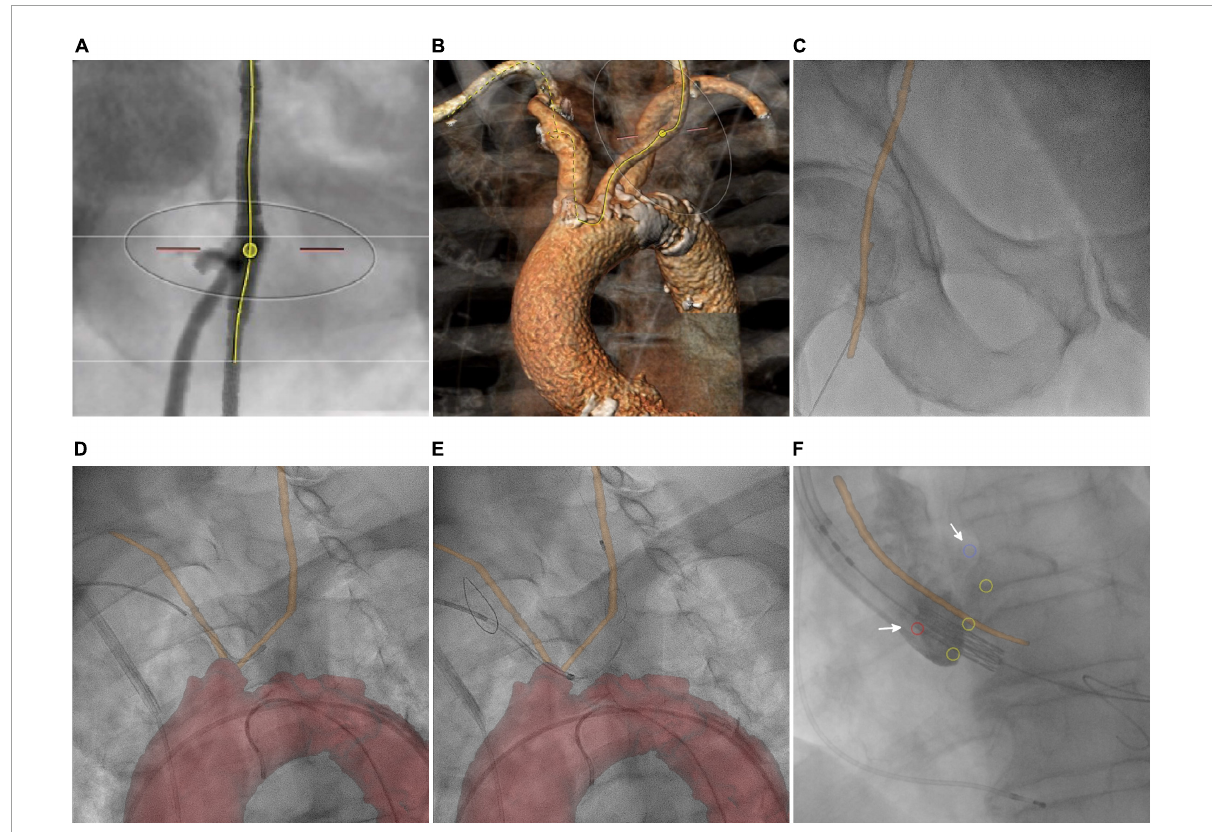
FIGURE3 Transcatheter aortic valve replacement. (A) CTA-based determination of the transfemoral puncture site. (B) Volume rendering shows the route for implantation of the cerebral protection device. (C) Overlay of the femoral centerline on fluoroscopy. Image fusion of the patient-specific vascular centerline (orange line) during (D) and after (E) implantation of the cerebral protection system. (F) Depiction of aortic cusp hinge points (yellow circles), coronary ostia (red and blue circle, arrows), and aortic centerline (orange line) during valve